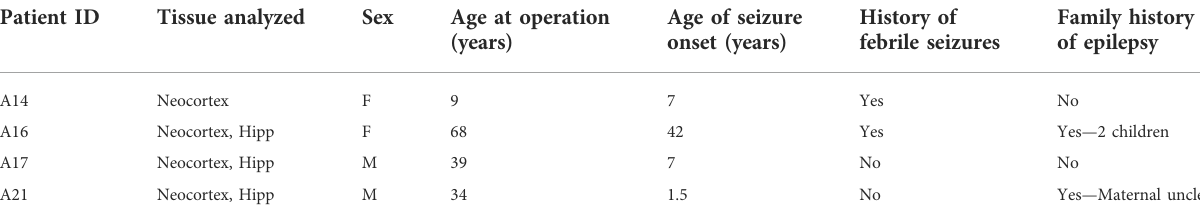
TABLE 1 Clinical information of temporal lobe epilepsy cases.